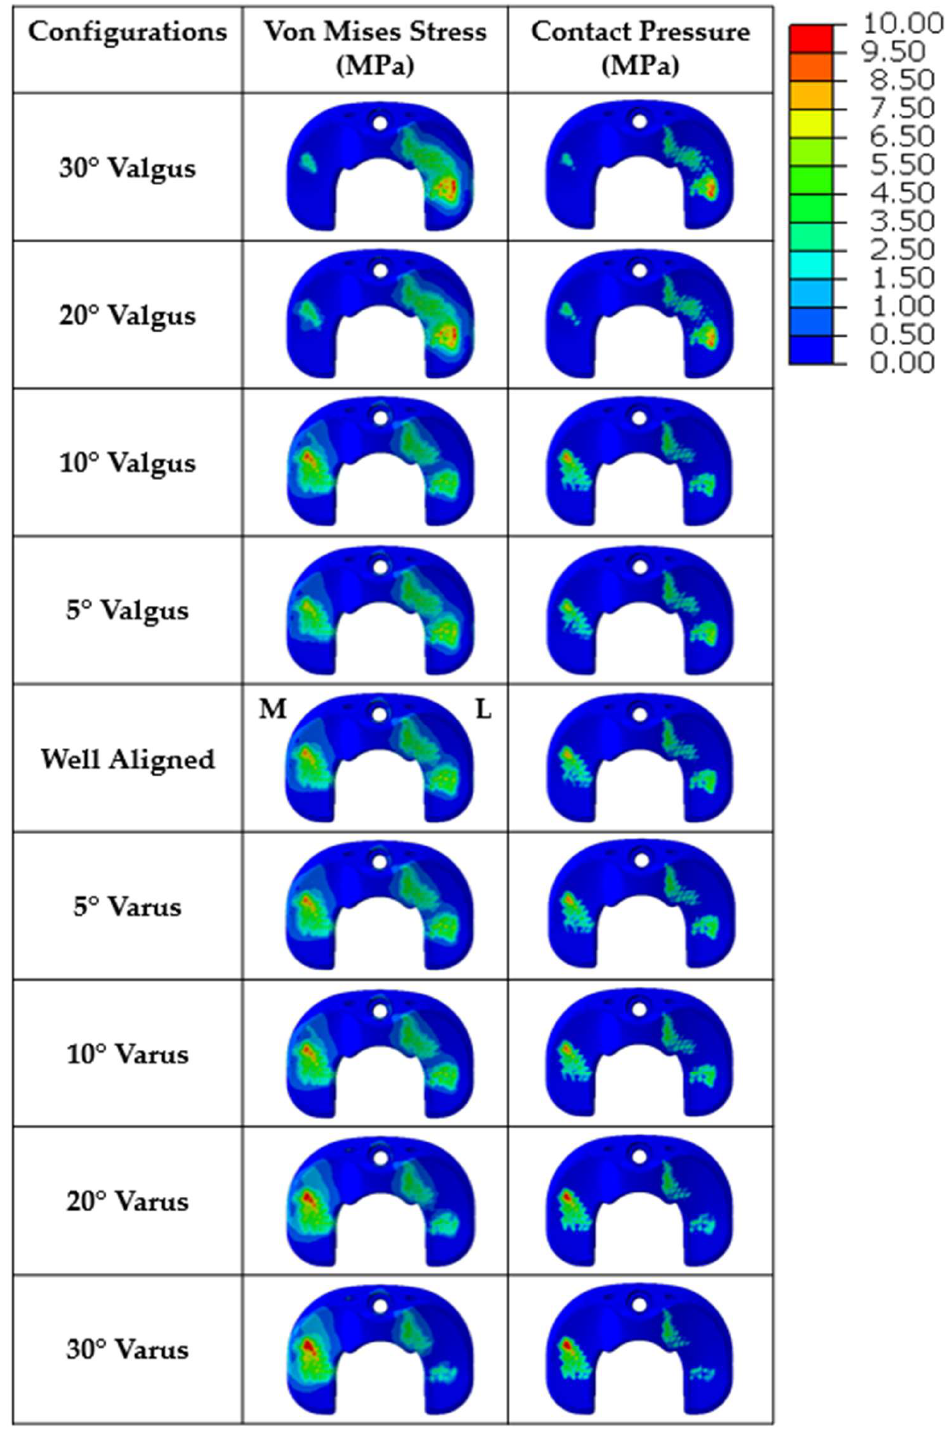
Figure 3. Qualitative overview of the von Mises stress distribution (in MPa) on the polyethylene insert and of the contact pressure (in MPa) and area on the polyethylene insert for the different varus/valgus configurations analyzed in the study, for a stem length of 50 mm cemented. M = medial, L = lateral.